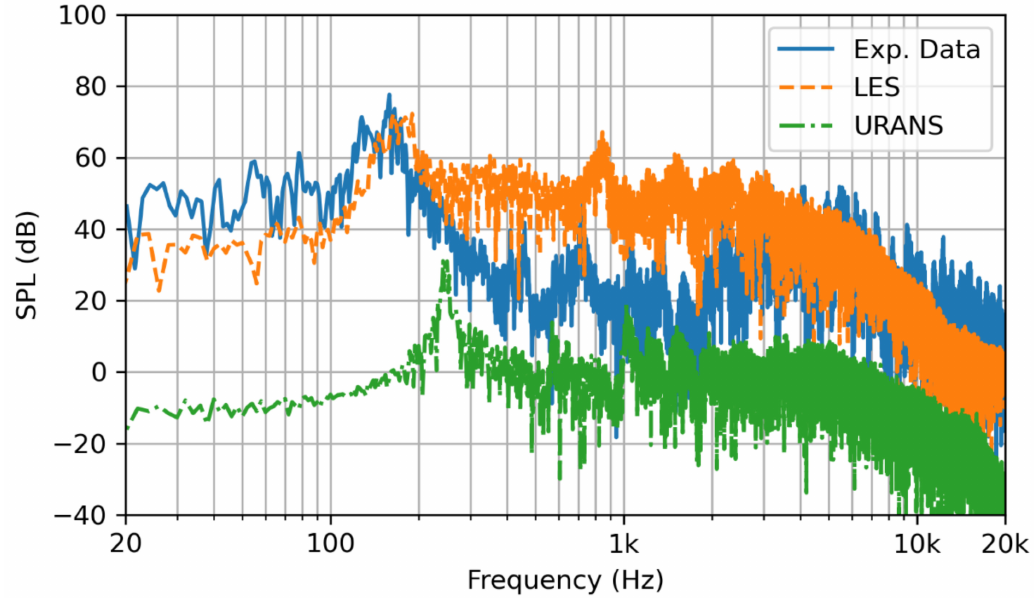
Figure 10. The SPL frequency spectrum for the measured noise (solid blue line) in comparison with the LES modeled noise (orange dashed line) and URANS modeled noise (green dash dotted